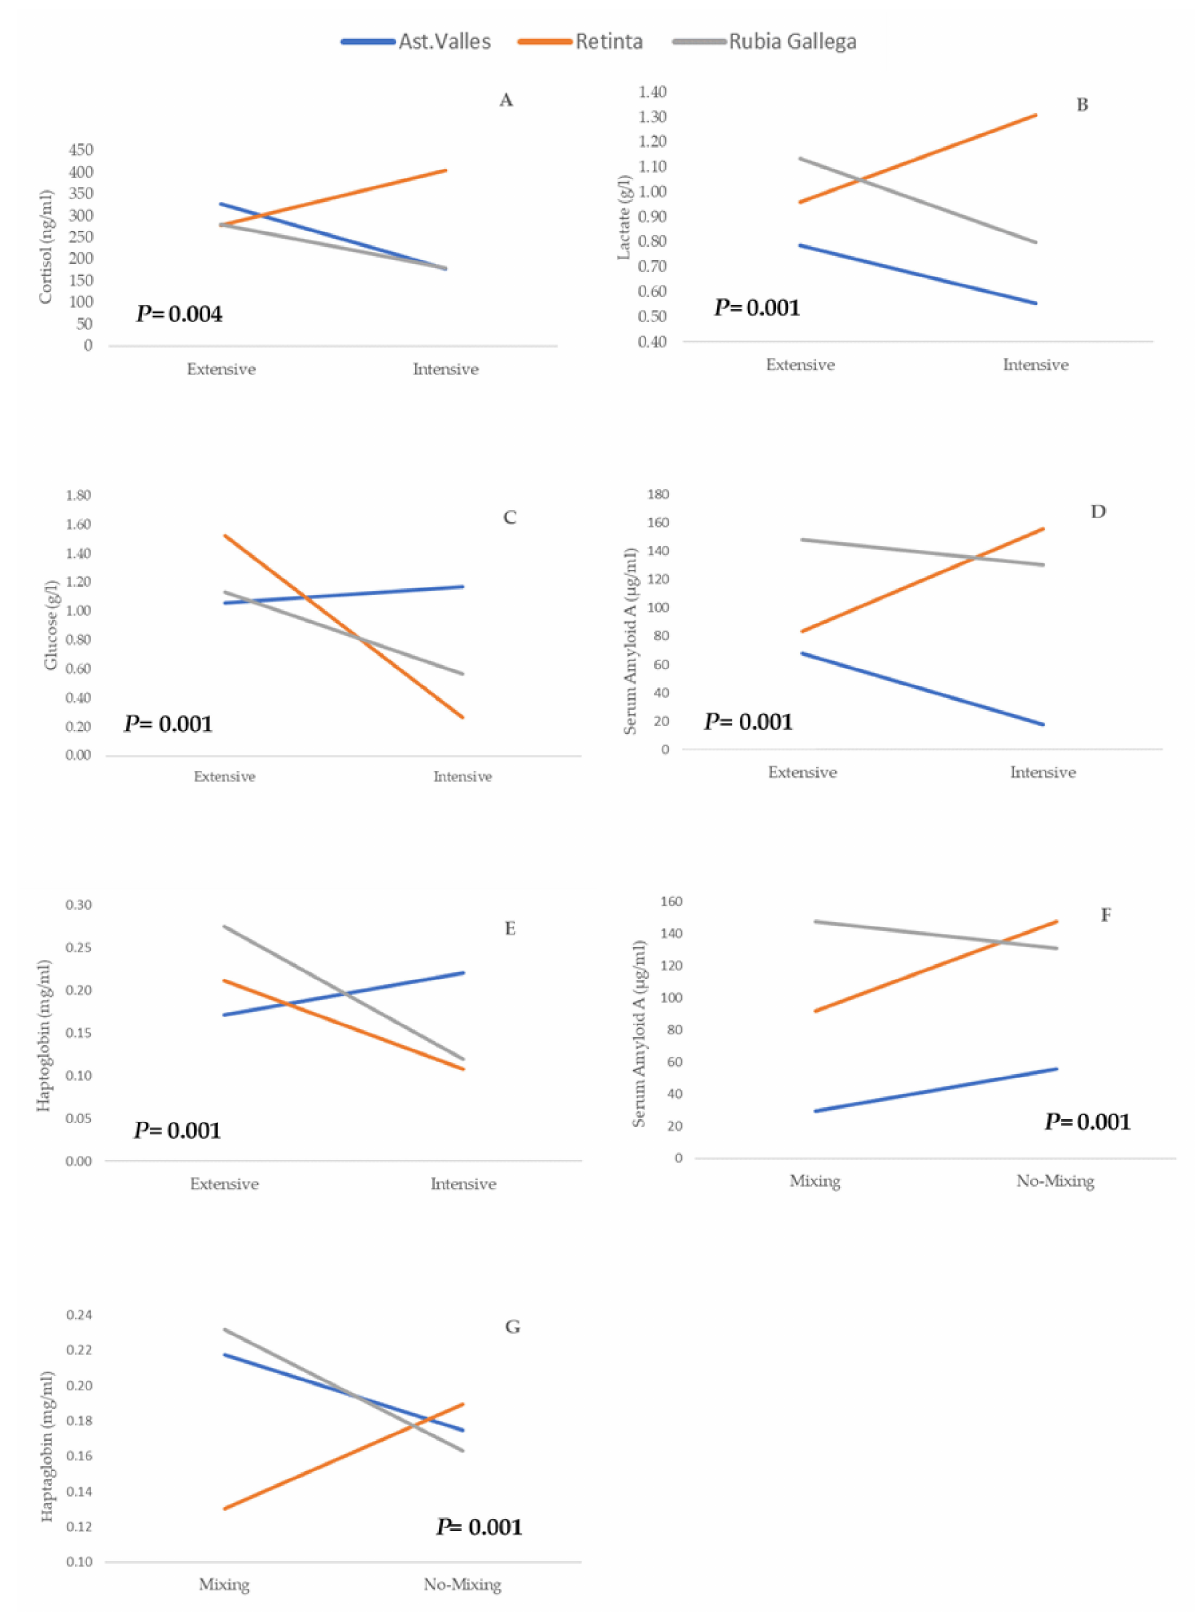
Figure 1. Interaction effects on serum biomarkers at slaughtering time (Ts). Interaction breed x farm management system on ( A ) cortisol, ( B ) lactate, ( C ) glucose, ( D ) serum amyloid A, and ( E ) haptoglobin. Interaction breed x pre-slaughter handling on ( F ) serum amyloid A and ( G ) haptoglobin. Extensive ( n = 39); intensive ( n = 39); mixing ( n = 40); no-Mixing ( n =